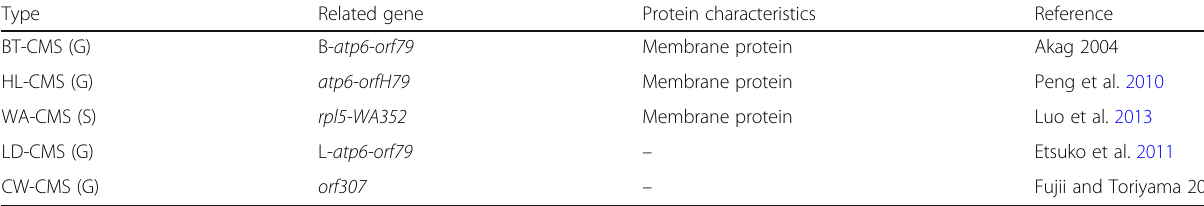
Table 2 CMS types and related genes in